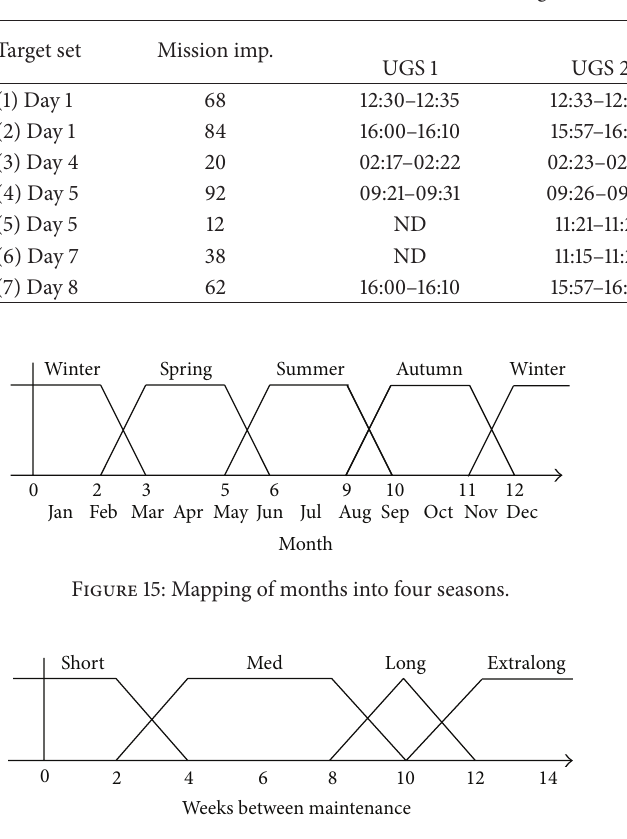
Figure 16: Weeks between maintenance mapping into categories.